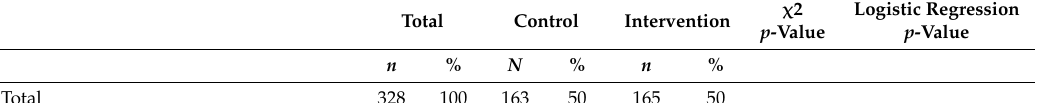
Table 2. Change in one year participation status comparison of SNAP, WIC, and food pantries by treatment group among Indiana SNAP-Ed participants using Chi-Square and logistic regression.